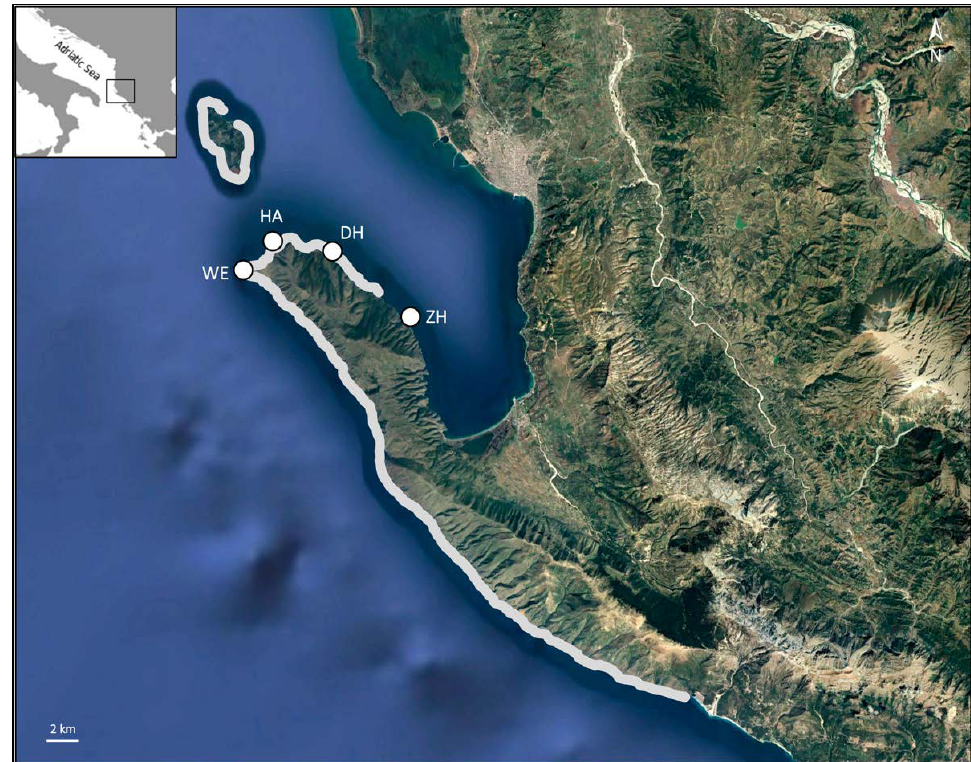
Figure 1. Map of Karaburun Peninsula with extension of the Karaburun-Sazan Marine Protected Area and the locations of the four sites: ZH = Zhapovel Bay, DH = Cape of Dhim Kushta, HA = Haxhi Ali Cave, and WE = Cape of Gjuhezes.